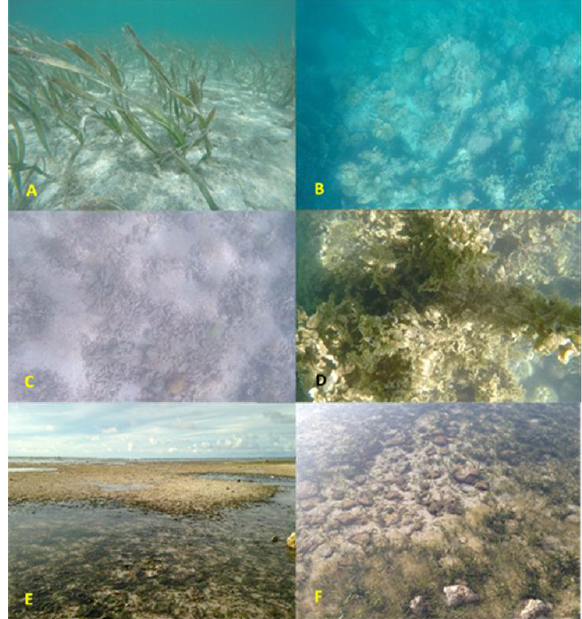
Figure 4. Samples of different benthic features observed in the Easter Samar during a field survey. A. Extensive seagrass (Enhalus acoroides); B. Live corals found in reef edges; C. Sand and coral rubbles; D. Seaweed (Sargassum sp.); E. Exposed intertidal area showing the